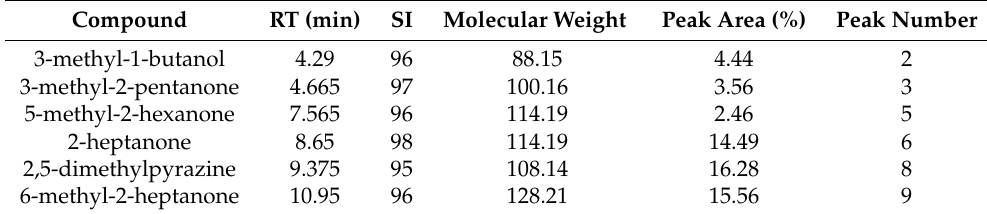
Figure 2. The volatiles were extracted by SPME and analyzed by GC-MS. LB medium ( A ); the GJ-7 strain fermentation broth ( B ). Peaks: (1) dimethyl-silanediol, (2) 3-methyl-1-butanol, (3) 3-methyl-2- pentanone, (4) hexamethyl-cyclotrisiloxane, (5) 5-methyl-2-hexanone, (6) 2-heptanone, (7) Oxime-, methoxy-phenyl-, (8) 2,5-dimethylpyrazine, (9) 6-methyl-2-heptanone, (10) benzaldehyde. Table 1. GC/MS analysis of strain GJ-7 fermentation